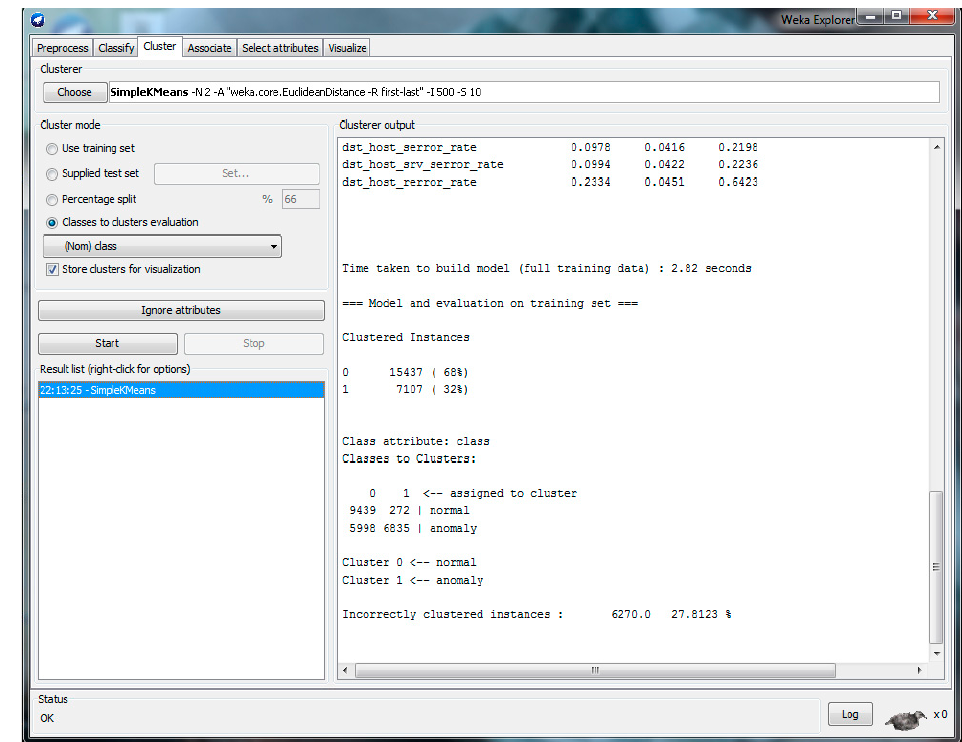
Figure 7. K-mean clustering result using a dataset with 22 attributes. Table 6. Confusion matrix for Table 6. Confusion matrix for K-mean.